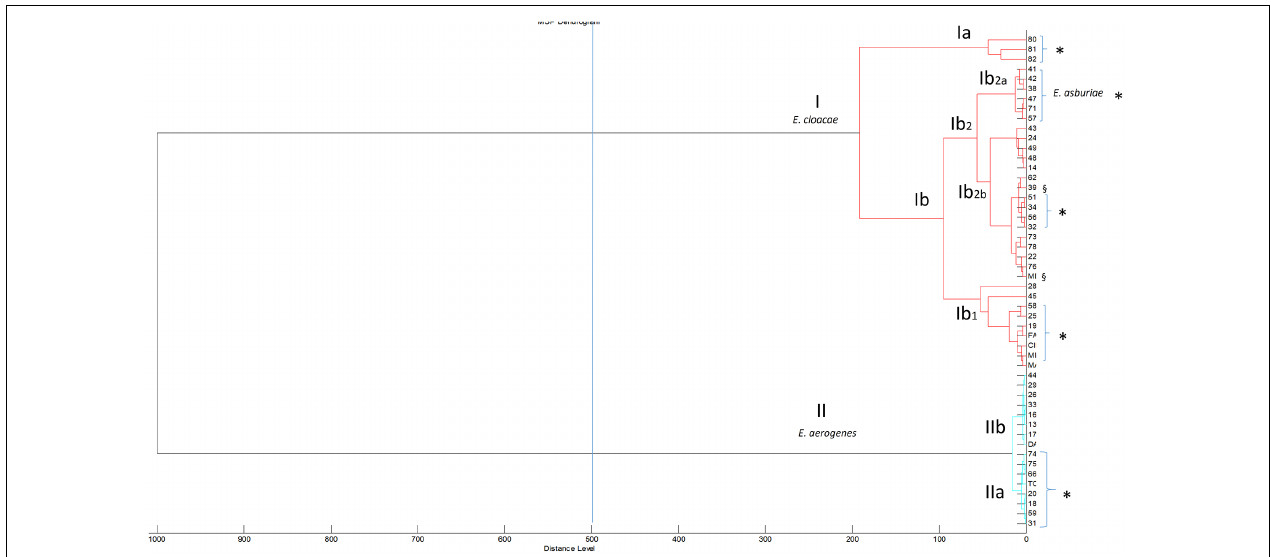
FIGURE 2 | Class dendrogram of all Enterobacter isolates built by the MALDI-TOF Biotyper 3.1 software. Asterisks ( ∗ ) identify strains isolated in general surgery and geriatric wards; the symbol § identify multidrug-resistant (MDR) strains.